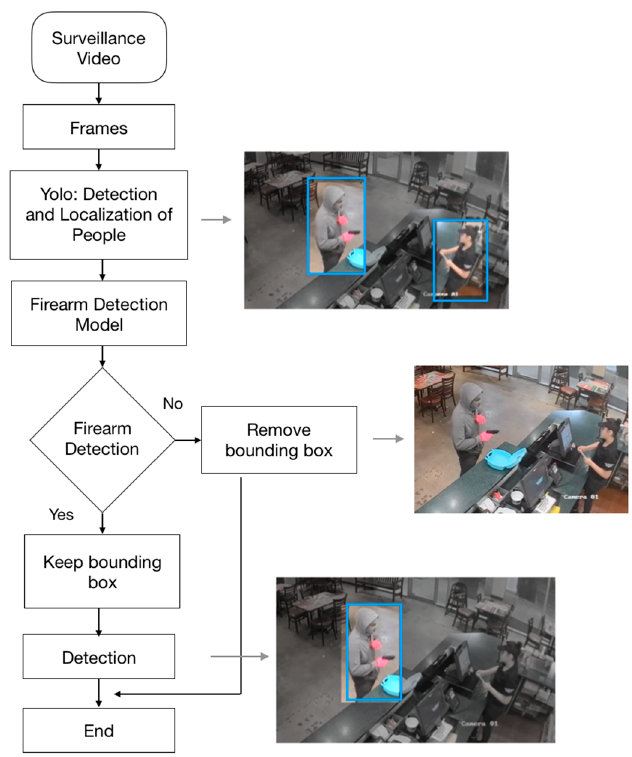
Figure 8. Firearm detection system.